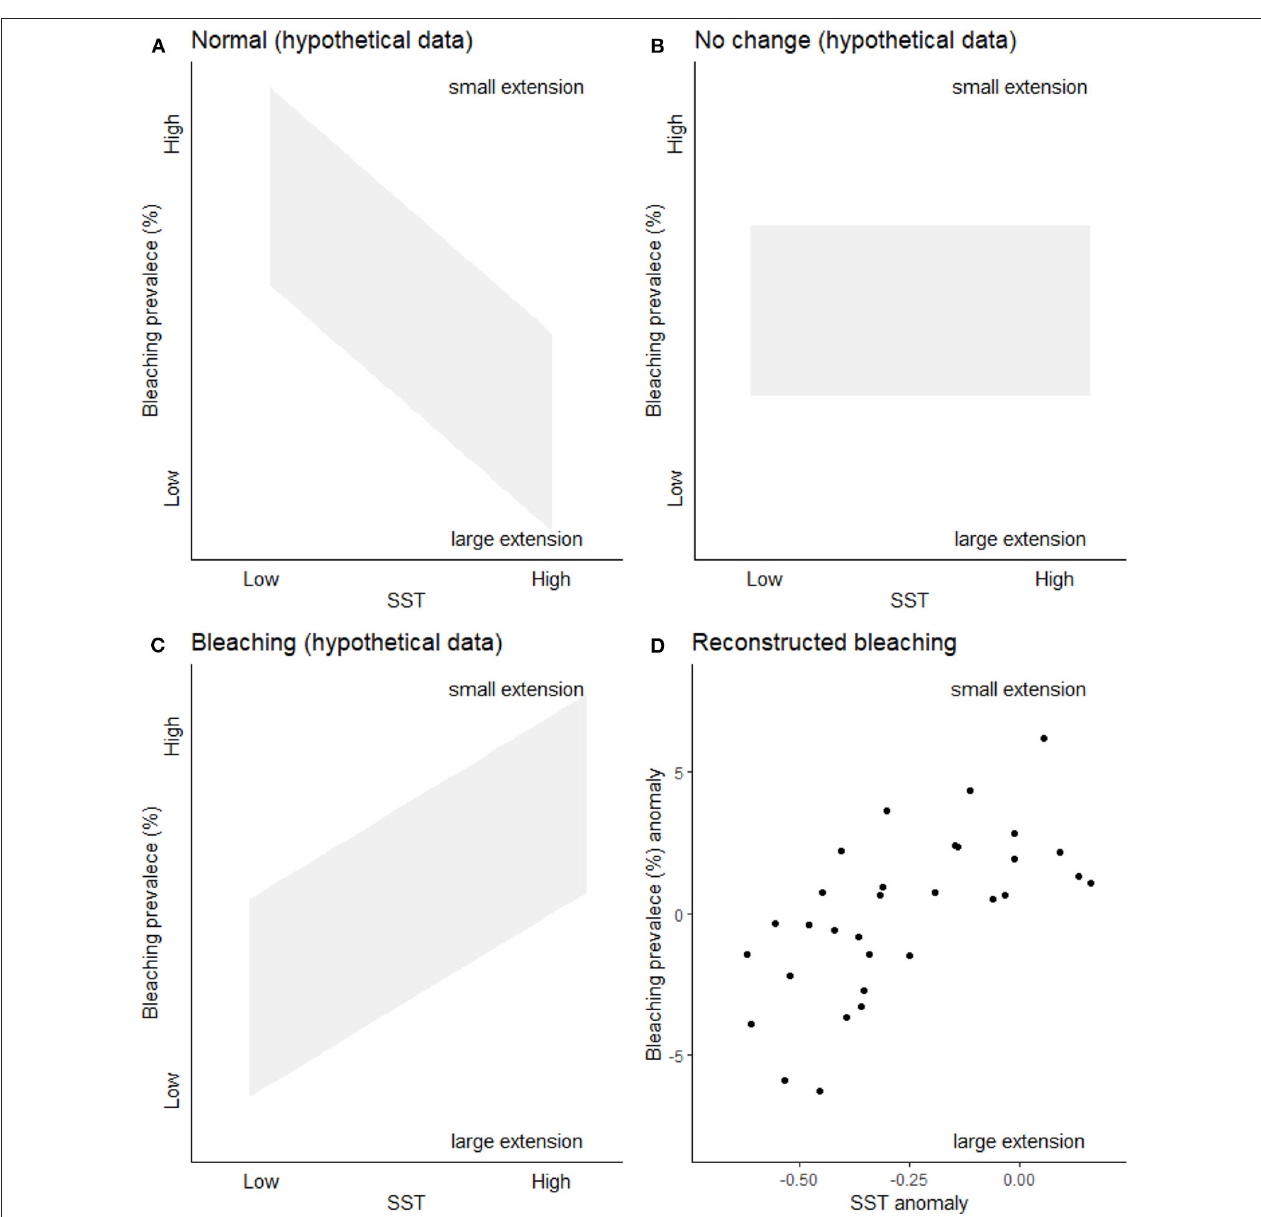
FIGURE 1 | Bleaching prevalence for different drivers. (A) Expected pattern if KH18 was reconstructing coral growth within physiological norms (as there would be fewer small growth bands at higher temperatures). (B) Expected pattern if KH18 was reconstructing coral growth within physiological norms and extension was also affected by other drivers including localized runoff for example. (C) Expected pattern if KH18 was reconstructing extension driven by bleaching. (D) Great Barrier Reef reconstructed bleaching prevalence (decadally binned anomaly) relationship with reconstructed western Pacific (Tierney et al., 2015) sea surface temperature anomaly (SST) between 1700 and 1989. Text in all plots indicates how the reconstructed bleaching prevalence relates to coral linear